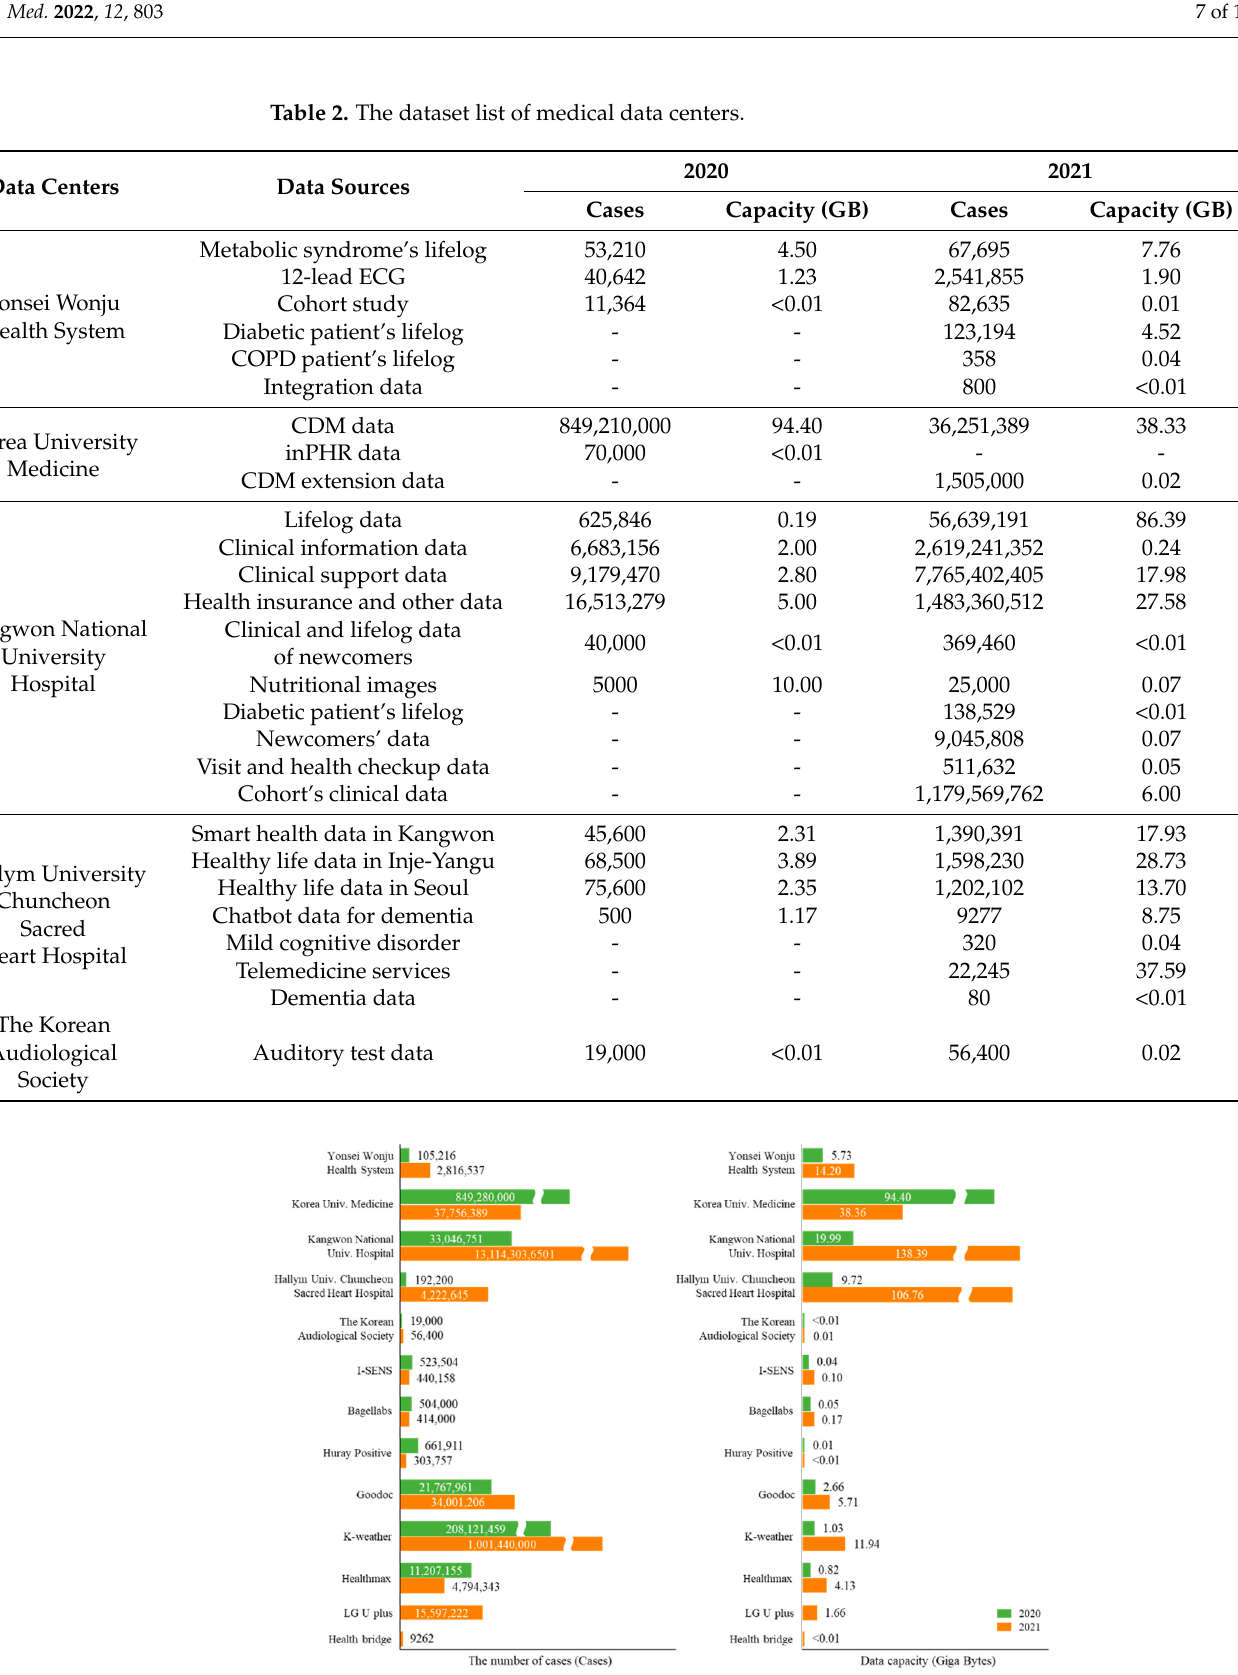
Figure 2. Data contribution in cases and capacity. Table 2. The dataset list of medical data centers.